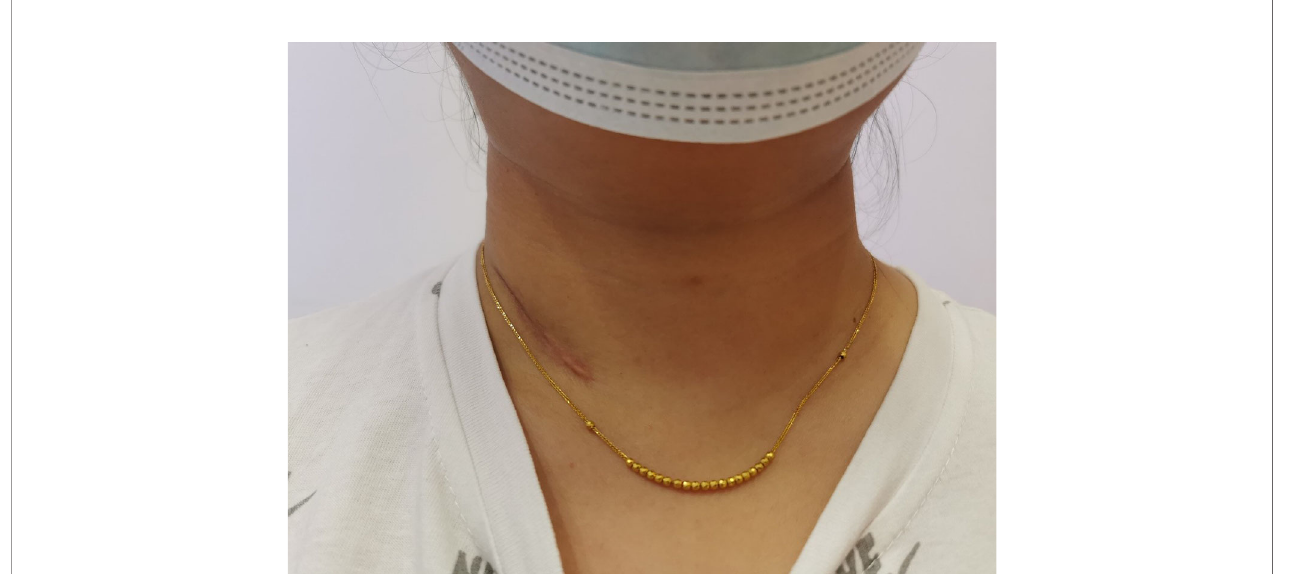
FIGURE 1 | The appearance of the incision 1 month after the operation is